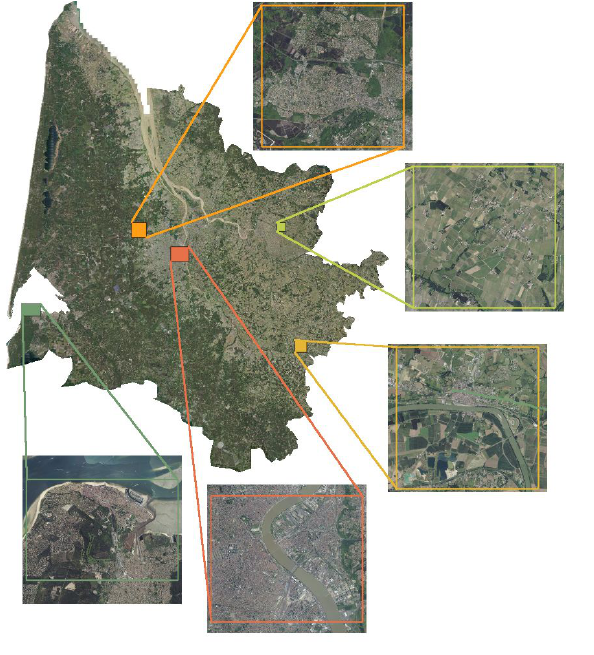
Figure 6. Training zones